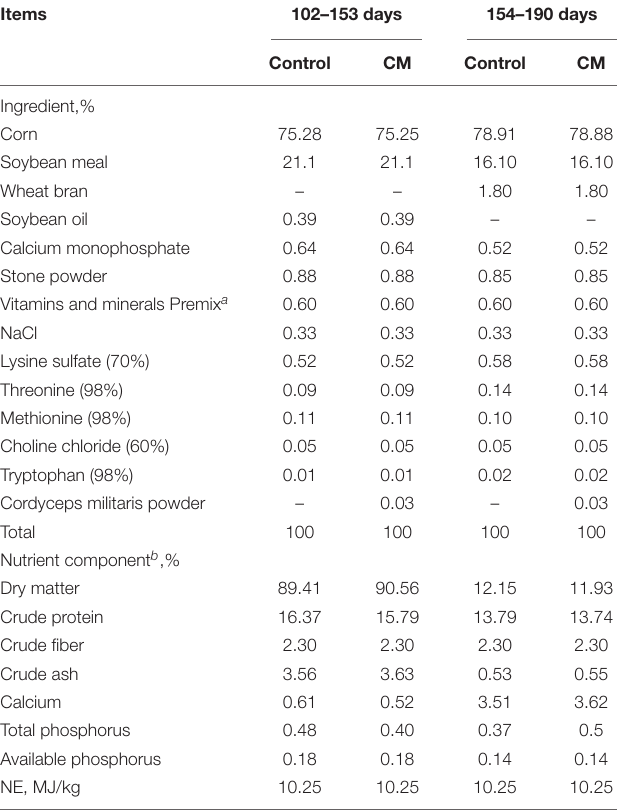
TABLE 1 | Ingredients and nutrient analysis of experimental diets.